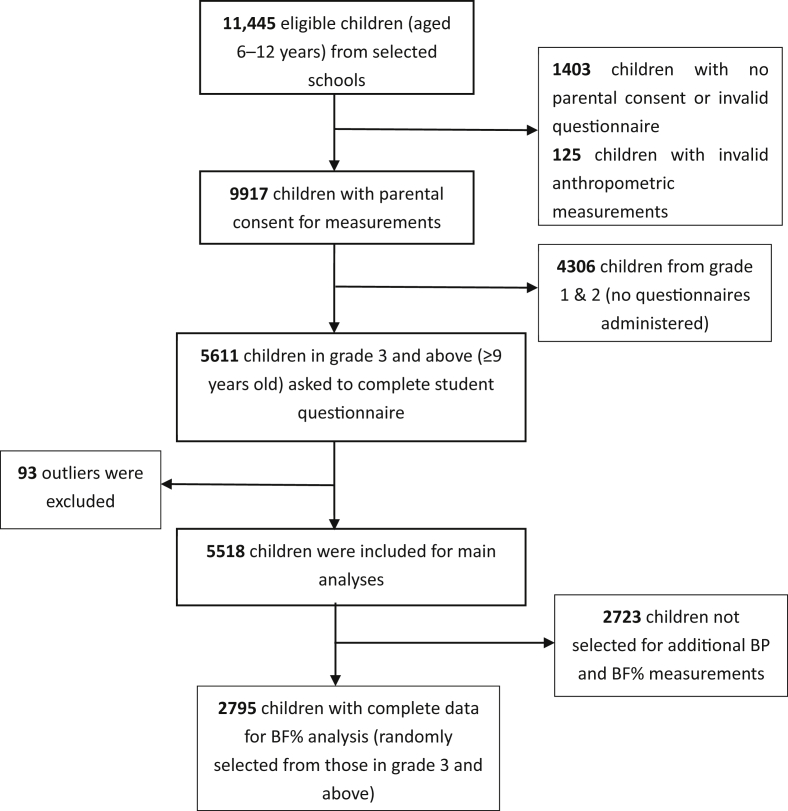
Flow chart of participants included in study.